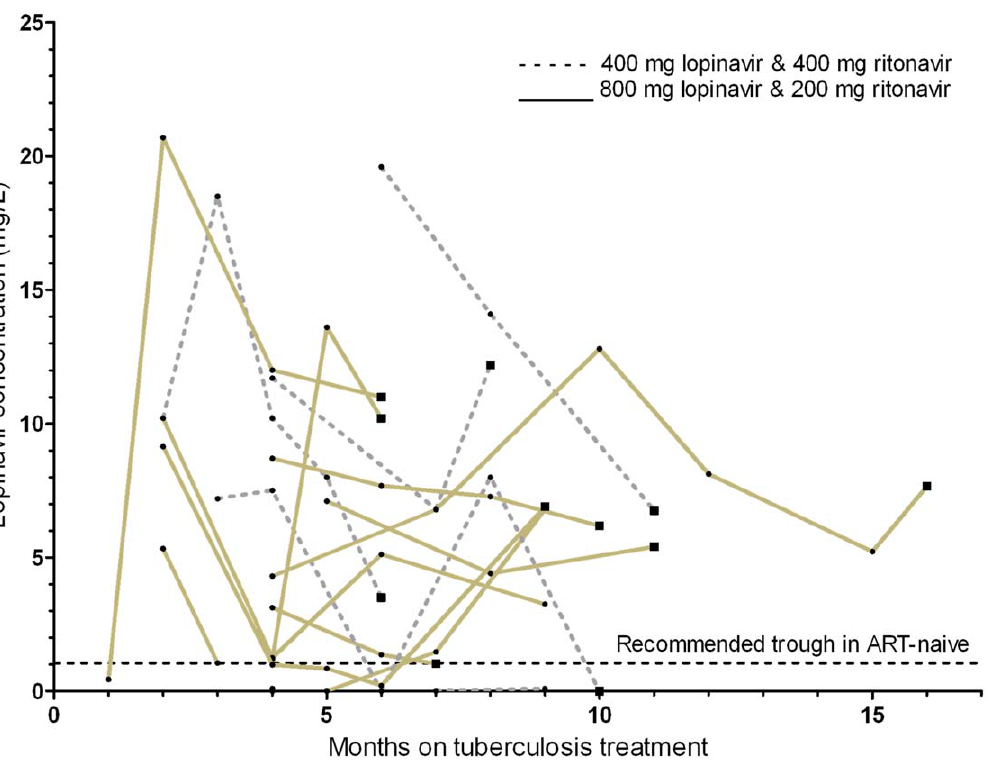
Figure 2. Lopinavir concentrations of individual patients during the study period. The circles indicate lopinavir concentrations measured while patients were receiving tuberculosis treatment, while the squares indicate lopinavir concentrations once tuberculosis treatment has been completed.